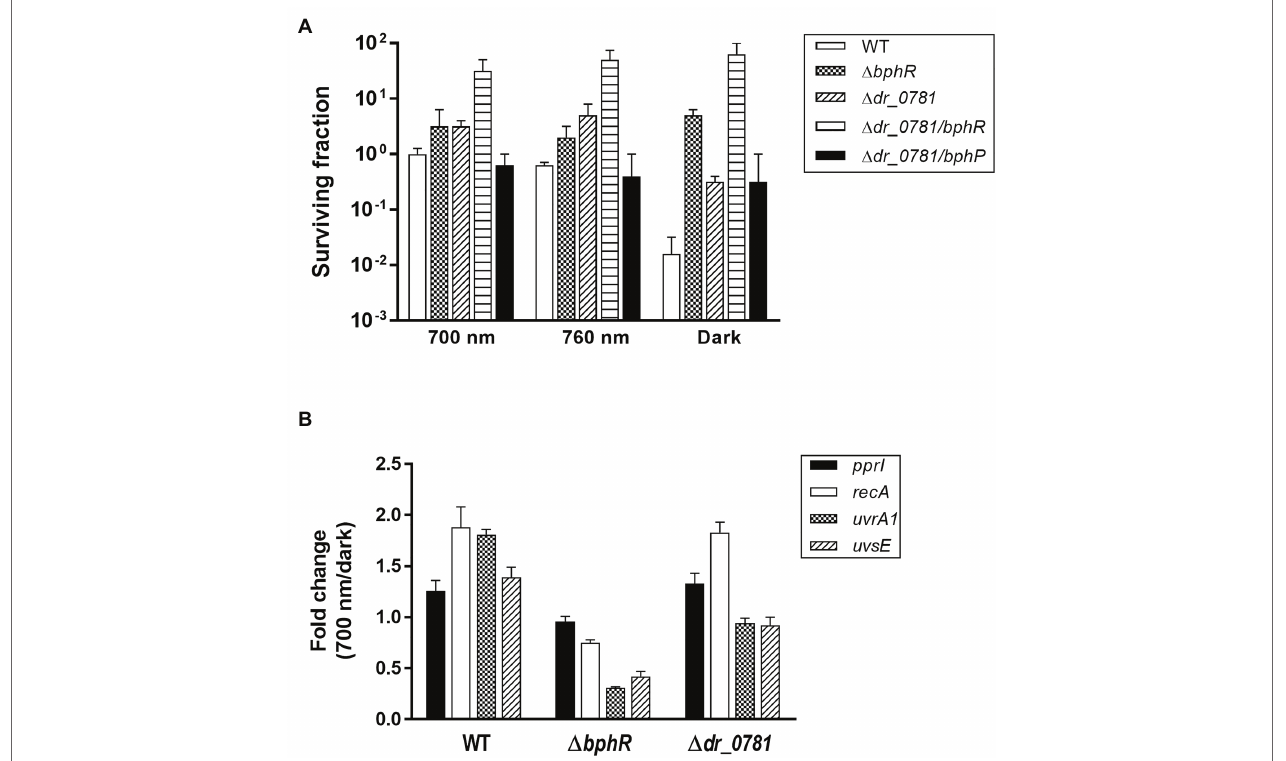
FIGURE 6 | Effect of dr _ 0781 mutation on MMC resistance. (A) Deinococcus radiodurans wild-type, dr _ 0781 , dr _ 0781 bphR , and dr _ 0781 bphP mutant strains were grown to log phase, then serially diluted, and spotted on TGY plates supplemented with 300 nM MMC. The plates were incubated under red light (700 nm), far-red light (760 nm), or no light (dark) conditions for 2 days prior to the enumeration of colonies. The surviving fraction was expressed relative to 700 nm-grown WT survival (arbitrarily set at 1). The error bars represent the SD of three independent experiments ( n = 3). (B) Quantitative real-time PCR (qRT-PCR) assay. Cells were grown to log phase (OD 600 ≈ 1.0) in the presence of MMC (300 nM) under red light (700 nm) and dark conditions, respectively. The relative expression values of indicated genes were determined by dividing the mRNA levels from the illuminated cells by the mRNA levels from cells kept in the dark. The expression levels of the target genes were normalized against dr _ 1343 . The data are represented as the mean ± SD of three independent experiments performed in